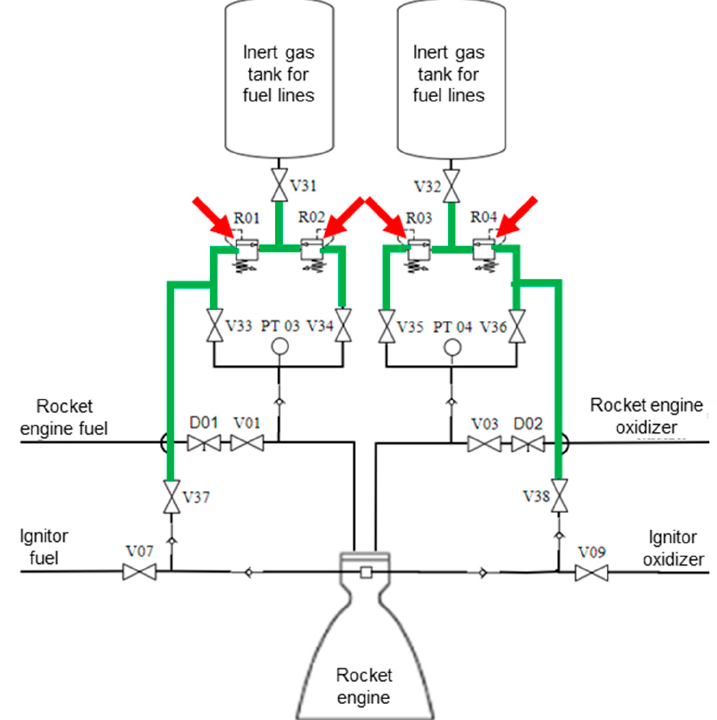
Figure 13. Algorithm’s third step diagram.